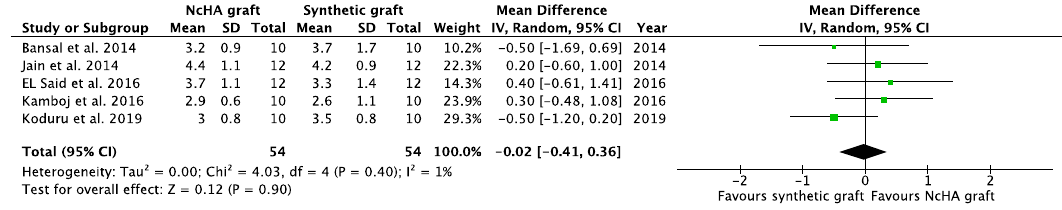
Figure 7. Forest plots demonstrating the comparison of NcHA graft versus synthetic graft (PPD reduction). NcHA: nanohydroxyapatite IV: inverse variance; SD: standard deviation; Total: number of patients; 95% CI: confidence interval.